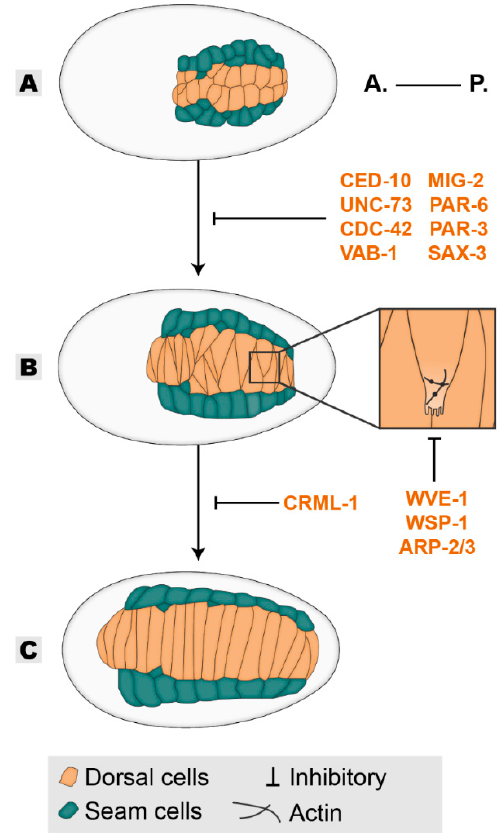
Figure 1. Dorsal intercalation. Epithelial cells are born dorsally as two rows ( A ), the dorsal cells reorganize their shape to intercalate within themselves ( B ) covering the dorsal length of the embryo ( C ). Players in orange are required in the epidermis for dorsal intercalation. All inhibitory signs are representative of the outcome of the absence of a player. Embryos oriented with anterior (A.) on the left and posterior (P.) on the right.